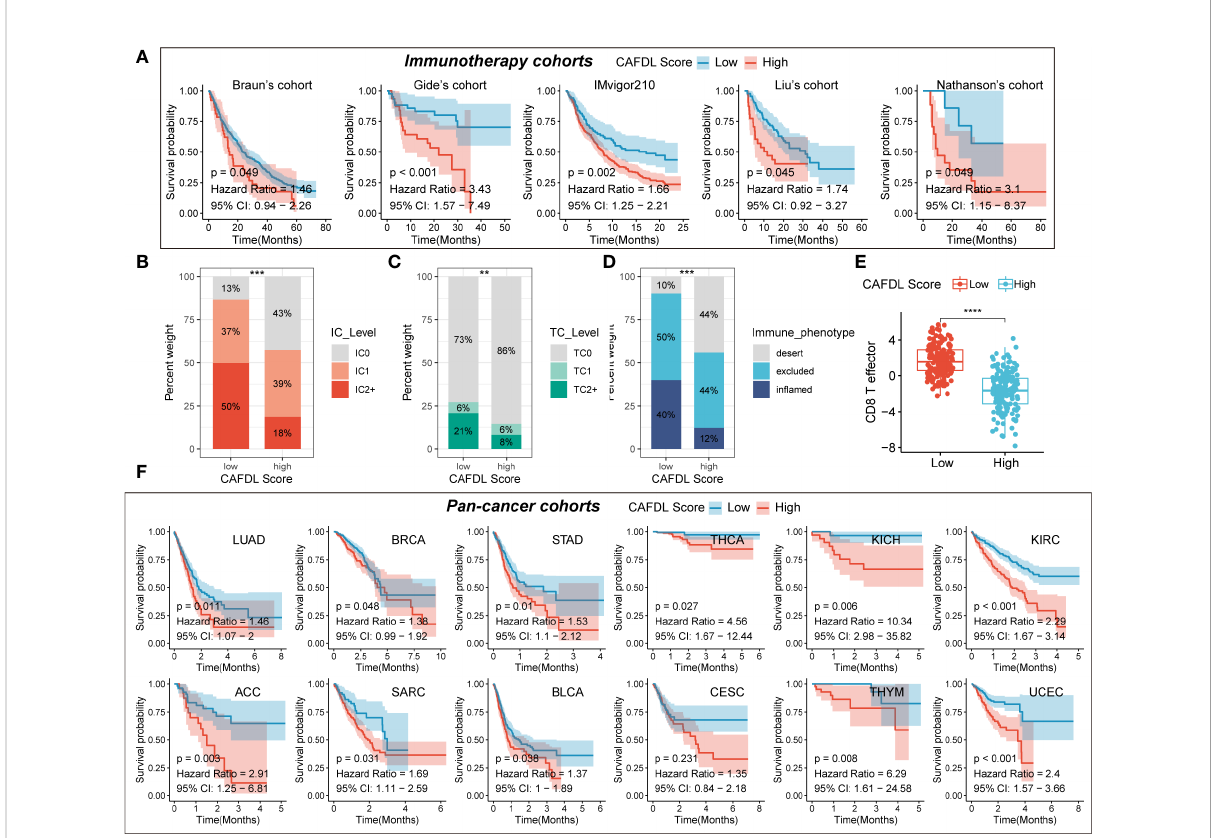
FIGURE 5 CAFDL signature predicts clinical outcomes in immunotherapy cohorts and pan-cancer cohorts. (A) Patients with high CAFDL scores have signi fi cantly worse overall survival than those with low CAFDL scores in Braun ’ s, Gide ’ s, IMvigor210, Liu ’ s, and Nathanson ’ s cohorts. (B, C) In the IMvigor210 cohort, patients in the low CAFDL score group had signi fi cantly higher PD-L1 protein expression levels in immune cells (B) and tumor cells (C) . (D) The high CAFDL score group had higher proportion of immune desert phenotype and lower proportion of immune-in fl amed phenotype. (E) The high CAFDL score group had signi fi cantly lower CD8 + T effector in fi ltration. (F) In addition to COAD and READ, patients with high CAFDL scores have signi fi cantly worse overall survival than those with low CAFDL scores in 12 TCGA datasets: LUAD, BRCA, STAD, THCA, KICH, KIRC, ACC, SARC, BLCA, CESC, THYM, and UCEC. **P < 0.01, ***P < 0.001, and ****P <